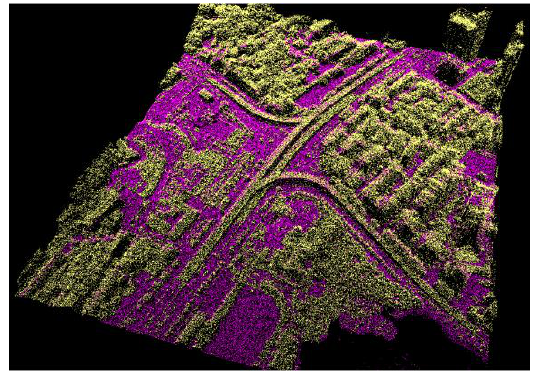
Figure 4. Filtered Point Cloud.